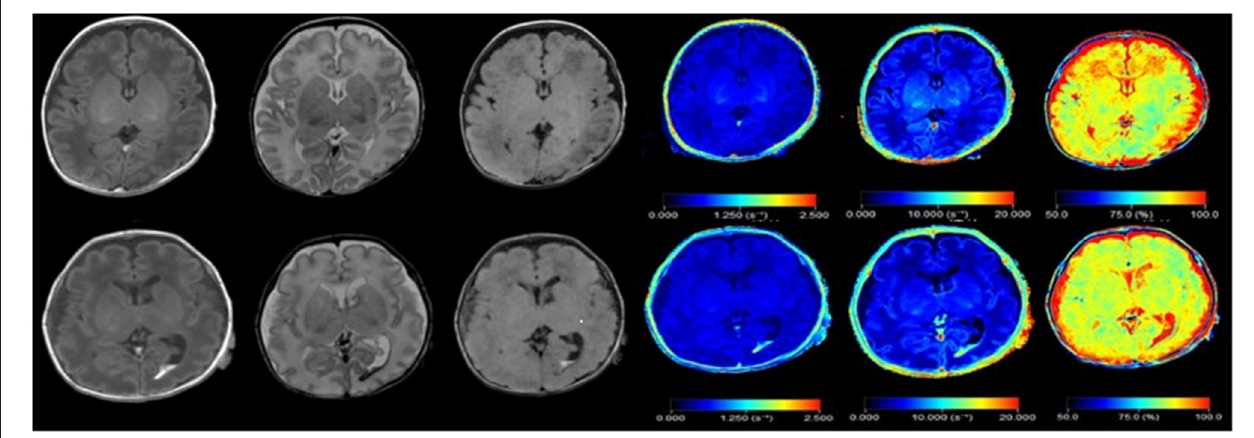
FIGURE 1 | Synthetic images of a normal premature infant, and premature infant with intraventricular hemorrhage. Upper row: Synthetic MRI of normal preterm infants, in order of T1, T2, T2 FLAIR, R1, R2, PD. Bottom row: Synthetic MRI of premature infants with intraventricular hemorrhage, in order of T1, T2, T2 FLAIR, R1, R2, PD. (R1 = 1/T1, R2 =